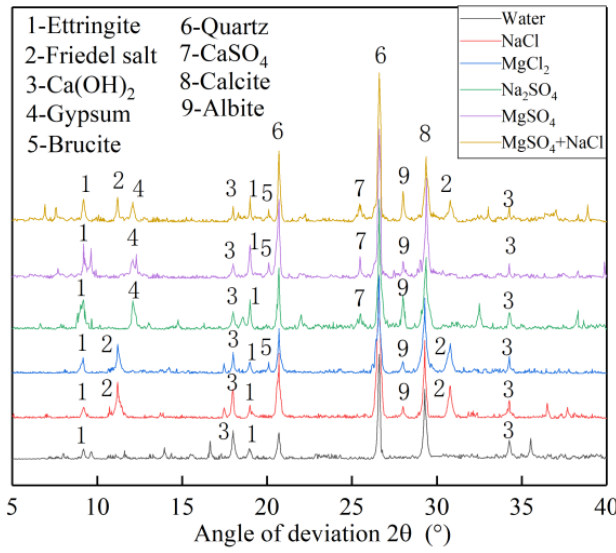
Figure 11. XRD diagram of 30 dry-wet cycles.